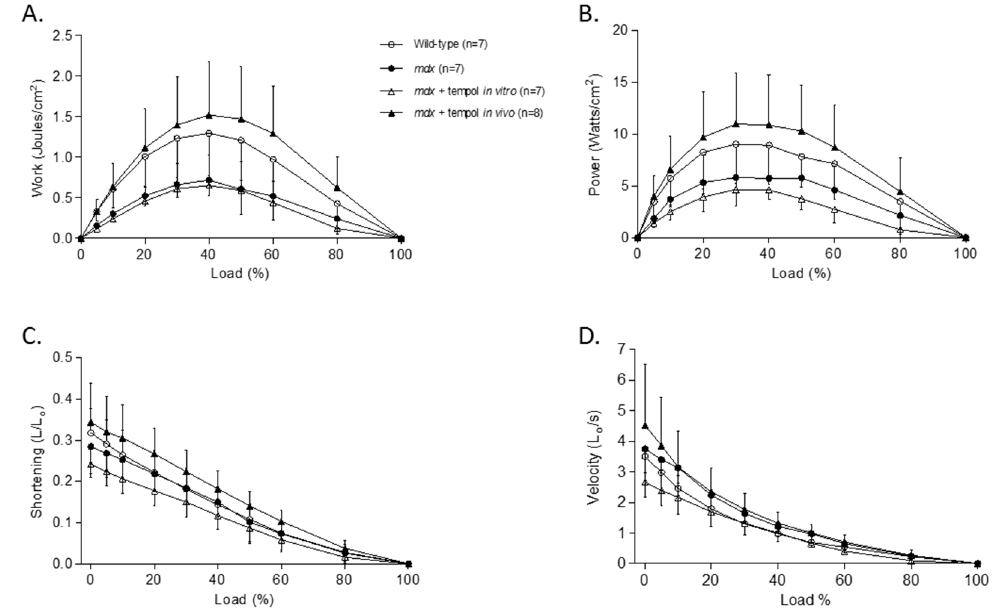
Figure 2. Diaphragm Muscle Isotonic Contractile Properties. Group data (mean ± SD) for work—( A ), power—( B ), shortening—( C ) and shortening velocity—( D ) load relationships for diaphragm muscle from wild-type ( n = 7), mdx ( n = 7), mdx + tempol in vitro ( n = 7) and mdx + tempol in vivo ( n = 8). For